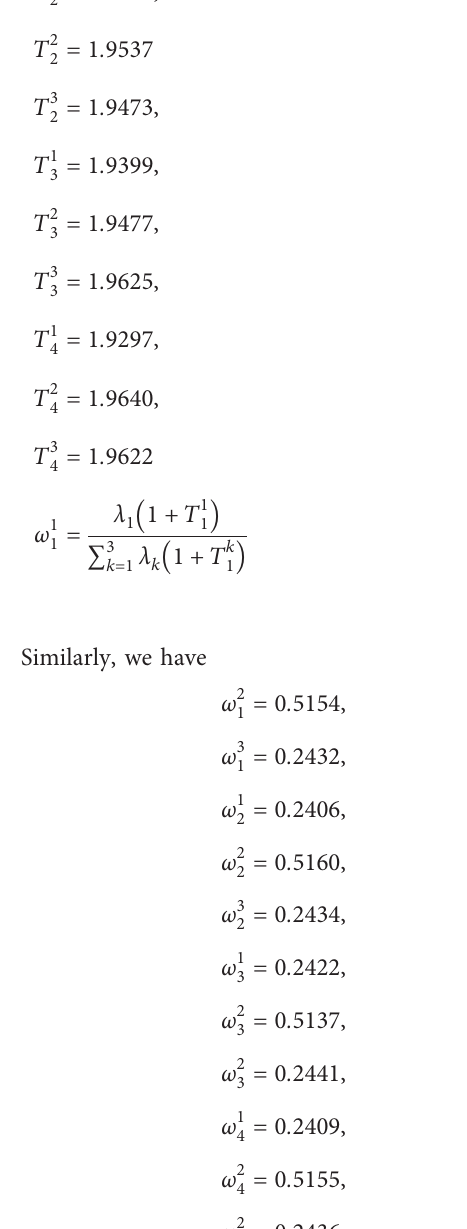
� Sup ( Z k , Z t ) are obtained i i i